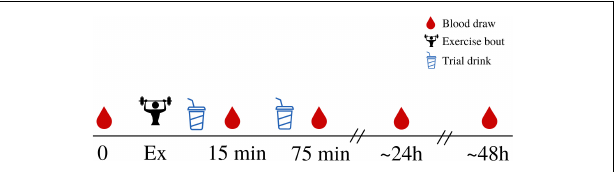
FIGURE 1 | An overview of the experimental trial. Participants arrived for a baseline, rested, fasted blood draw before completing the exercise protocol. Immediately following completion of the exercise protocol, participants consumed the first trial drink (either MILK or CHO) which was then immediately followed by a blood draw (approximately 15 min after cessation of exercise). This was repeated 1 h later, with a second, identical, trial drink consumed 1 h after the first drink, and a second blood draw taken after the second drink had been consumed (approximately 75 min after cessation